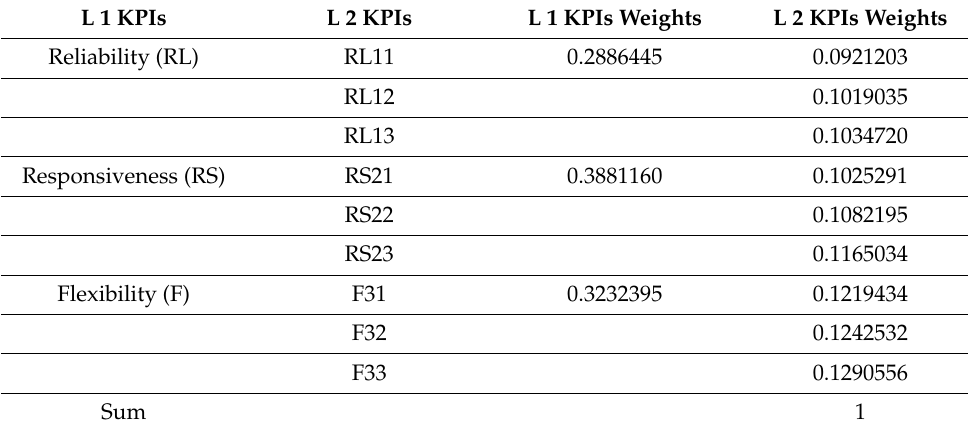
Table 4. Net weights for levels 1 and 2 KPIs for scenario 1.